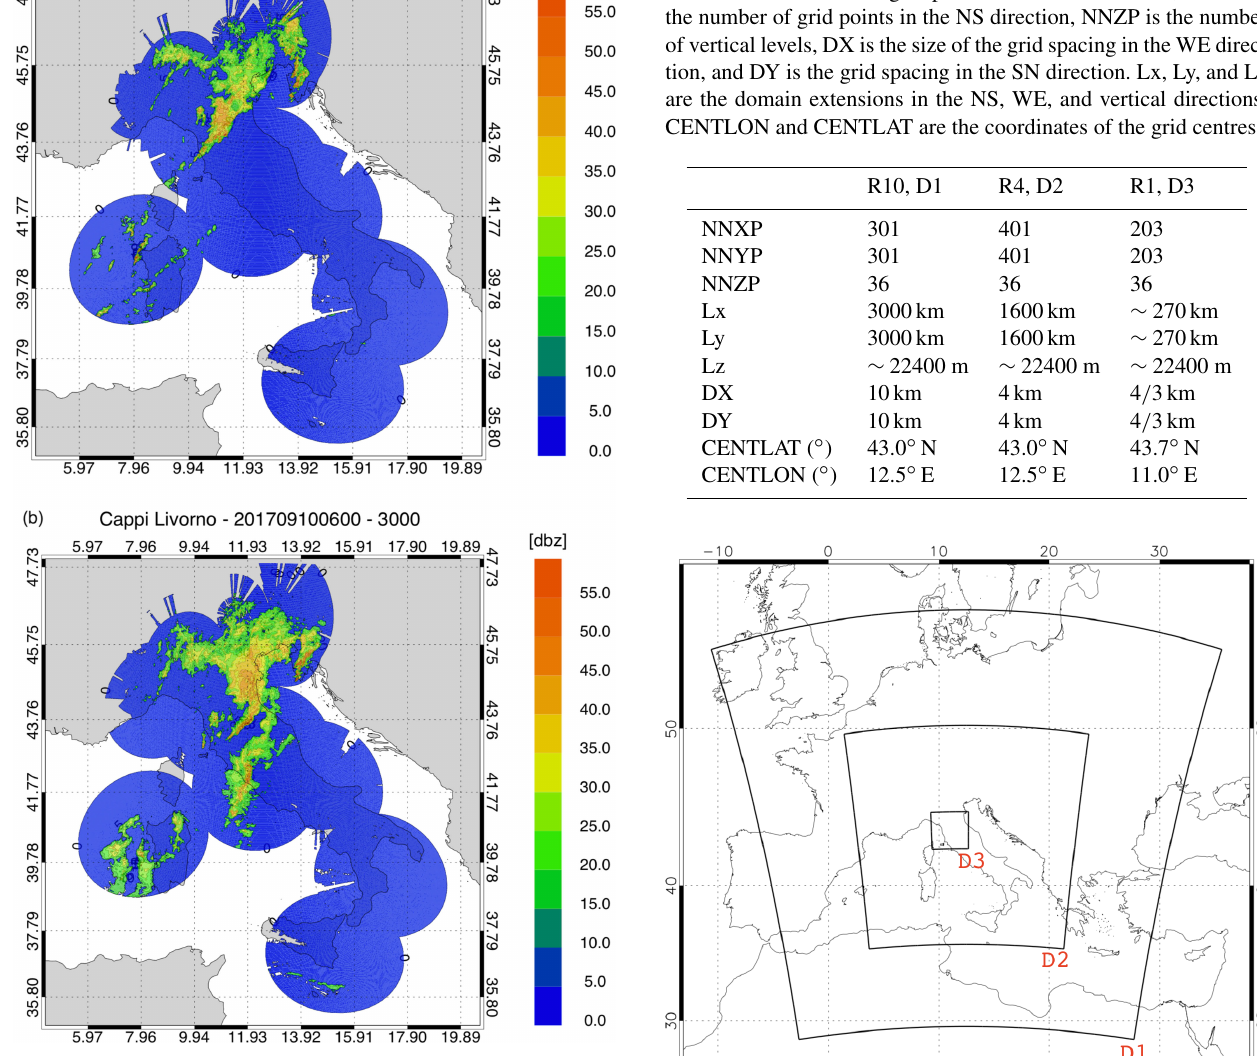
Figure 10. (a) National radar mosaic at 3km above the sea level observed at 00:00UTC on 10 September 2017; (b) as in (a) at 06:00UTC.